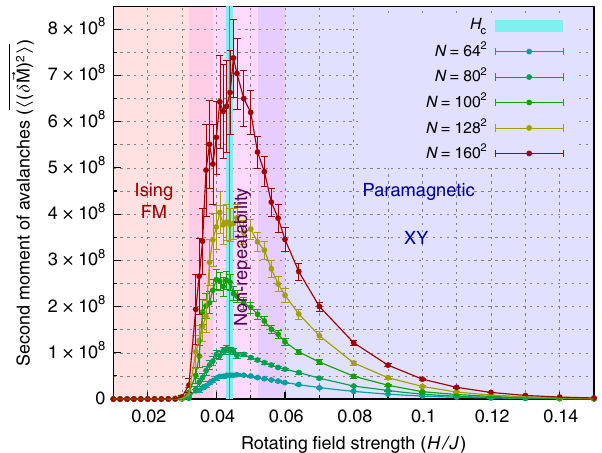
Fig. 7 This fi gure shows the zero temperature phase diagram as a function of the strength of the rotating fi eld in a uniaxial random fi eld. The region where the number of multiperiodic loops and the maximum periodicity increases with system size is labeled as the expected region of non-repeatability for in fi nitely large systems. This region coincides with the region where the largest avalanche occurs is this system where 〈 H c 〉 = (0.0437 ± 0.0009) J , which is marked by the vertical blue line. The line plots shows that the disorder average of the second moment δ M of the avalanche size distribution where the error bars are the standard deviation over the disorder average as described in the text. The brackets < > denote an average over the limit cycle, and the overbar denotes a disorder phase transition. The dependence of this simple model upon history implies that experiments on XY systems in uniaxial ran- dom fi eld are particularly sensitive to disorder. Con fl icting experimental results could arise if hysteresis protocols are not closely monitored.